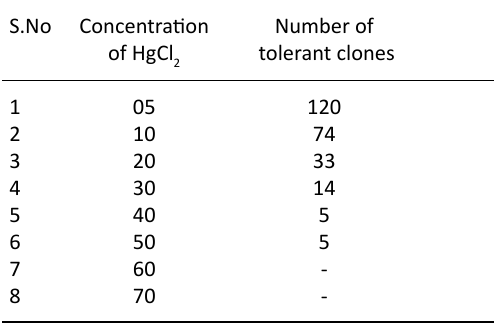
Table 3. Acclimatization of clones at different